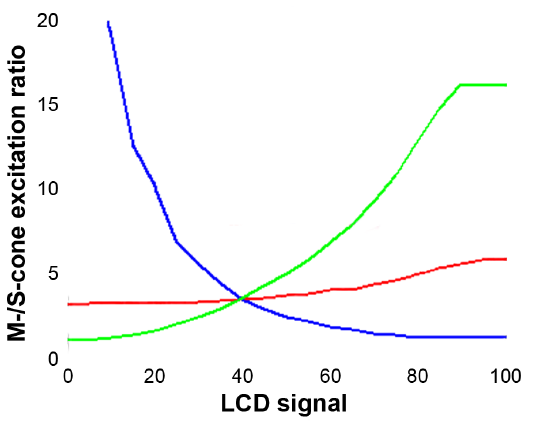
Figure 2. Conversion of measured LCD signals into M 2 /S-cone excitation ratios. Calibration of the three primary channels of the LCD monitor – red, green, and blue – made it possible to estimate the response strengths of M- and S-cones to any given colour signal and calculate the M 2 /S-cone excitation ratio.